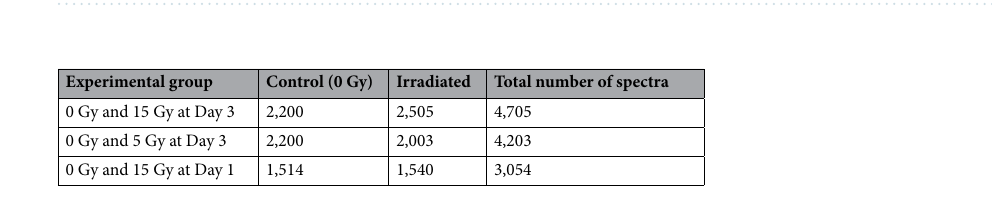
Table 2. Data set groups for CNN training, testing and validation.